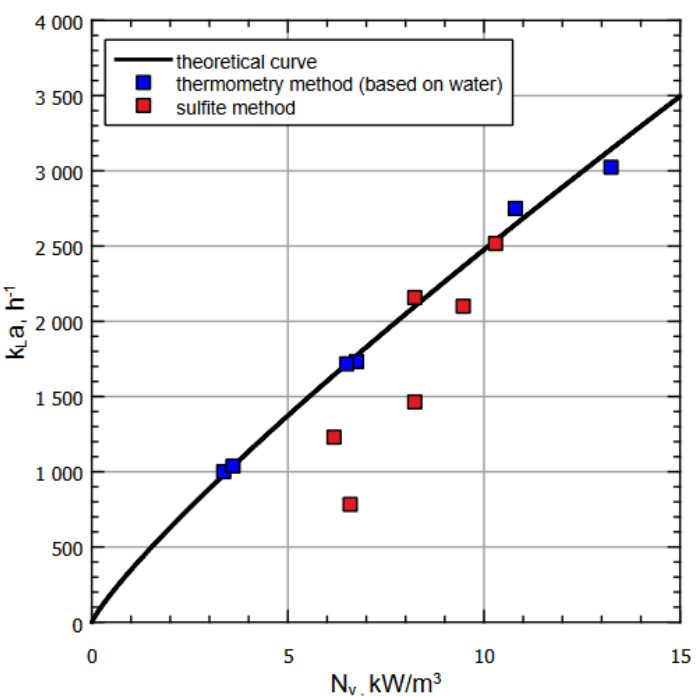
Figure 5. Dependence of k L a on N v for various liquids and methods of measuring k L a based on archive data (with working volume of the next order than the experimental setup considered